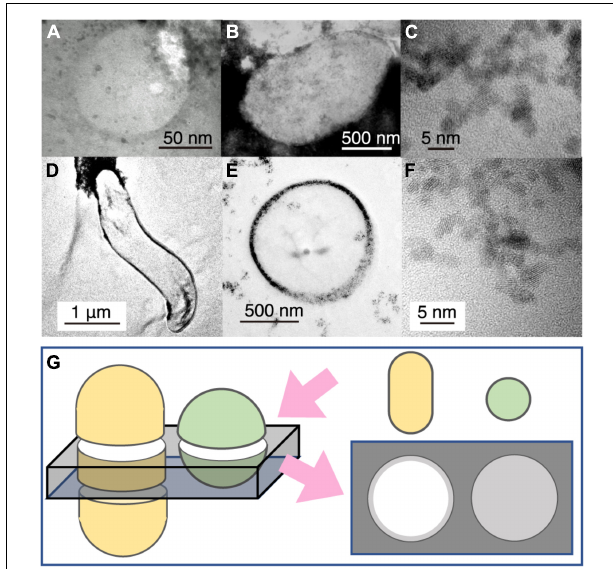
FIGURE 3 | Transmission electron microscopy (TEM) image contrast from microbial cells associated with extracellular nanoparticles. (A) Typical small sphere observed in Figure 2E . (B) TEM image of Geobacter sulfureducens extracellularly precipitated with uraninite nanoparticles. (C) High-resolution TEM image of uraninite nanoparticles produced by G. sulfureducens. (D,E) TEM image of Desulfovibrio desulfuricans with periplasmic uraninite nanoparticles. (F) , High-resolution TEM image of uraninite nanoparticles produced by D. desulfruicans. (G) Schematic explanation of the appearance of microbial cells extracellularly coated with nanoparticles by TEM observations. This illustration shows how a 150-nm thick FIB section was fabricated for rod and coccoid cells (left) and an expected TEM image from the FIB section (right). Gray color indicates the presence of extracellular nanoparticles in the right illustration. FIGURE 4 | Biological signatures determined by imaging mass spectrometry